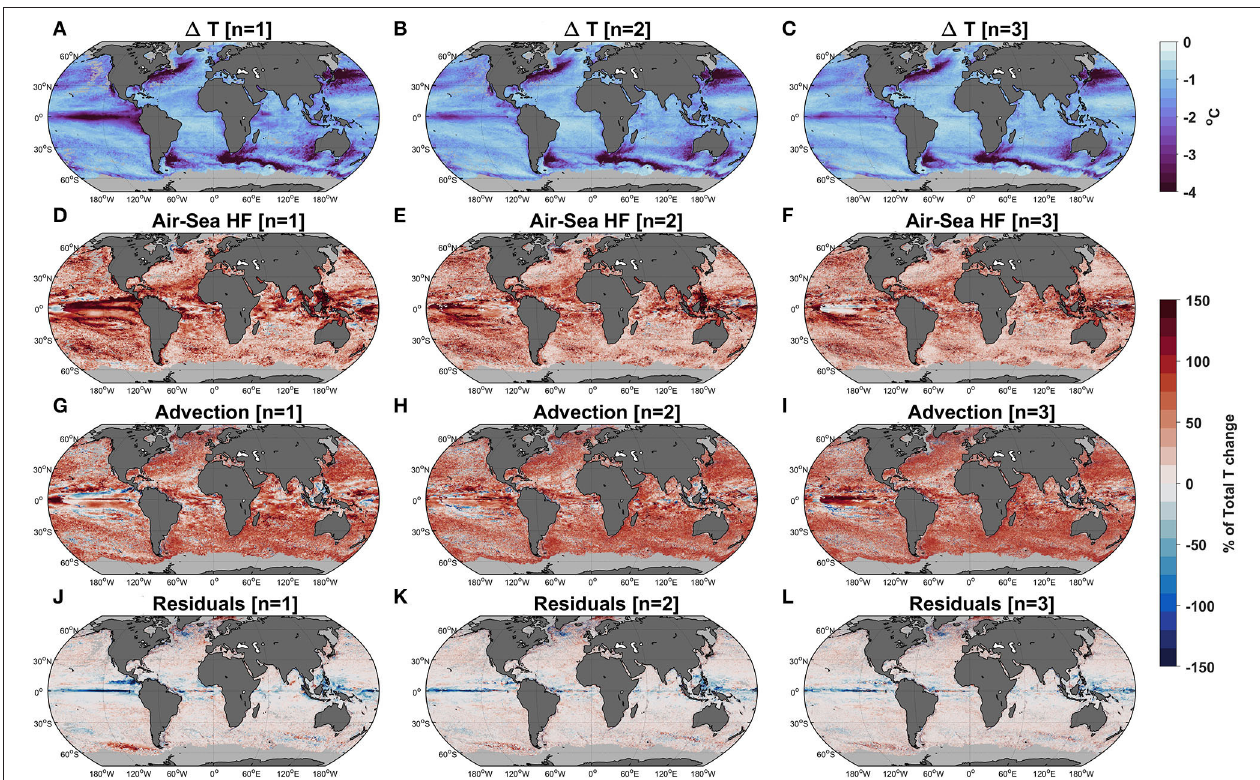
FIGURE 3 | Same as Figure 2 for the decay period. As temperature change is, by definition, negative during the decay period, positive/negative percentages indicate a cooling/warming contribution. Grid points where decay periods ended after Dec-31st 2014, or contaminated by sea-ice, were excluded from the analysis (gray